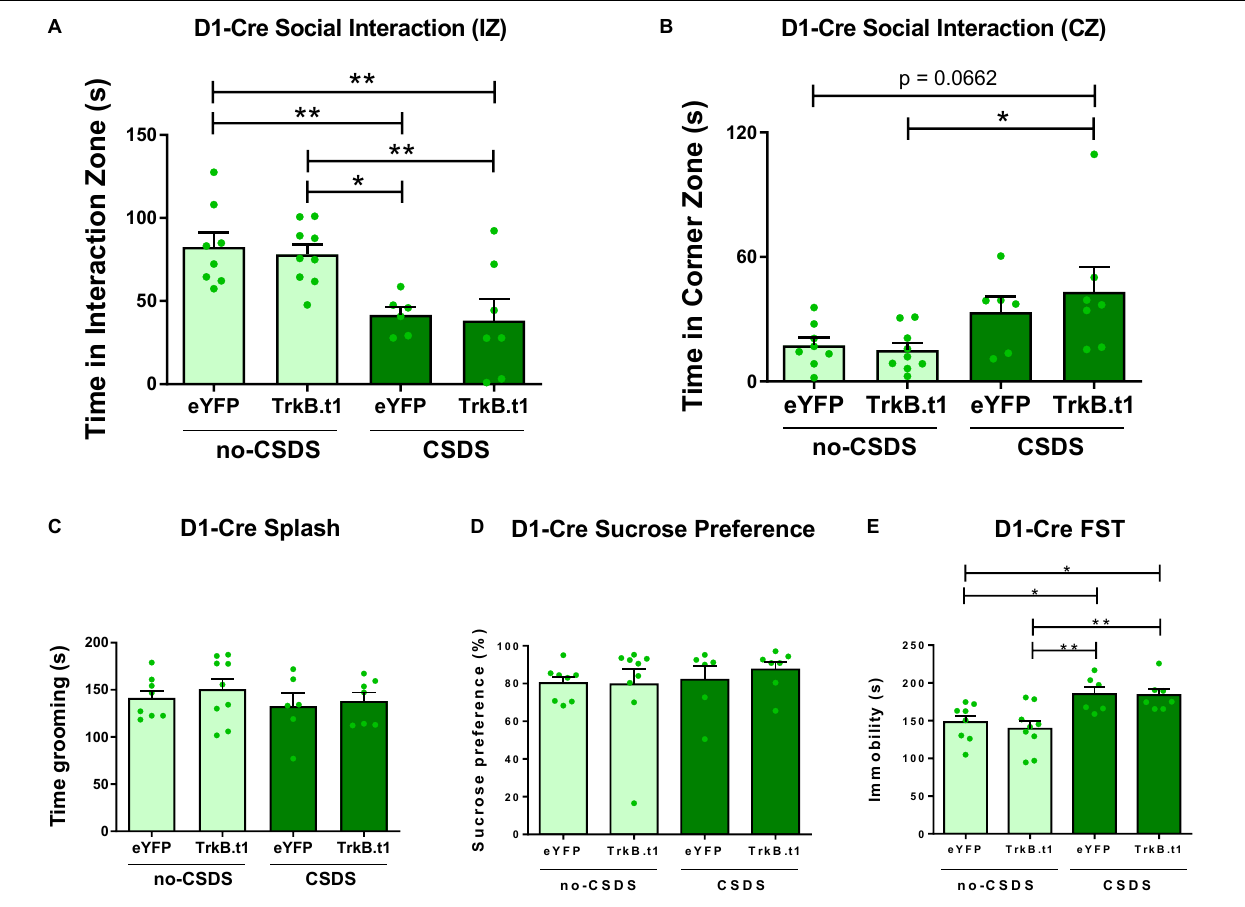
FIGURE 2 | Blocking BDNF-TrkB signaling in D1-MSNs did not induce a resilient phenotype after 10 days of social defeat stress (CSDS); instead, it induced a susceptible phenotype. (A) Both CSDS groups spent less time interacting with the social target, showing social avoidance ( N = 6–9). (B) CSDS-D1-MSN-TrkB.t1 group spent more time in the corner during the presence of the social target when compared with no-CSDS ( N = 6–9). (C,D) Total time spent grooming during the sucrose splash test or sucrose preference was not significantly different across groups ( N = 6–9). (E) Both CSDS groups demonstrated more time immobile in the forced swim test when compared with no-CSDS groups ( N = 6–9) (* p ≤ 0.05; ** p ≤